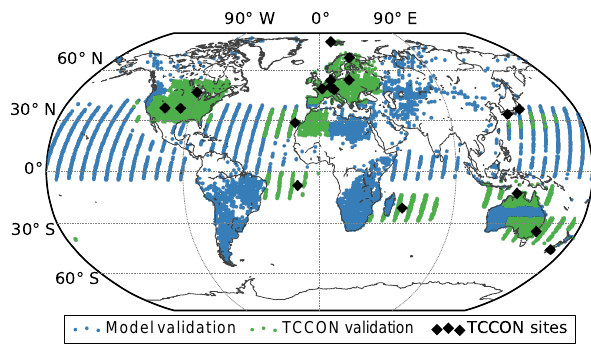
Figure 3. Global distribution and X CO 25000 GOSAT